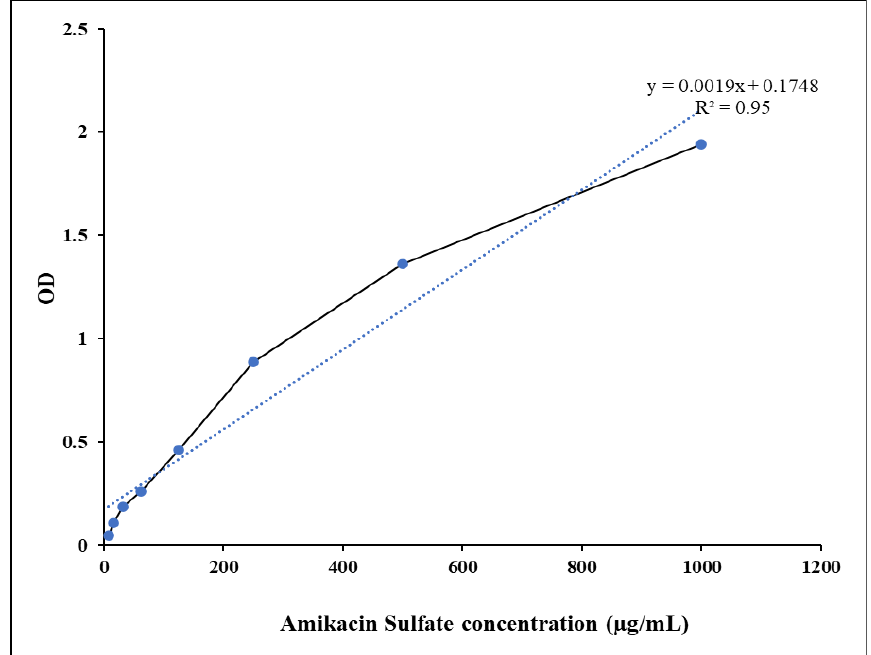
Figure 6. The standard curve of amikacin sulfate was determined at 270 nm .